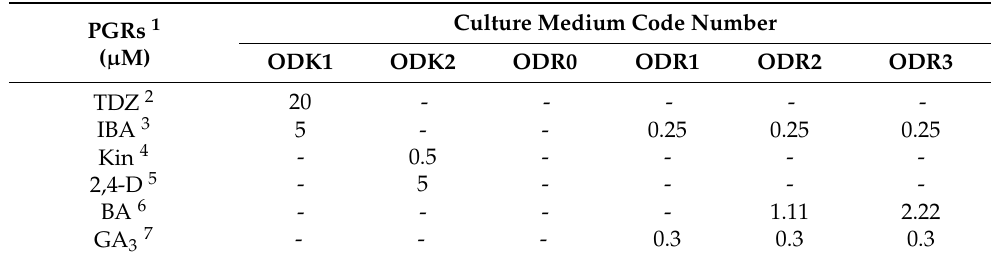
Table 3. Chemical composition of the different PGRs-supplemented MS basal culture media tested in this study for indirect in vitro organogenesis subsequent stages of O. dictamnus